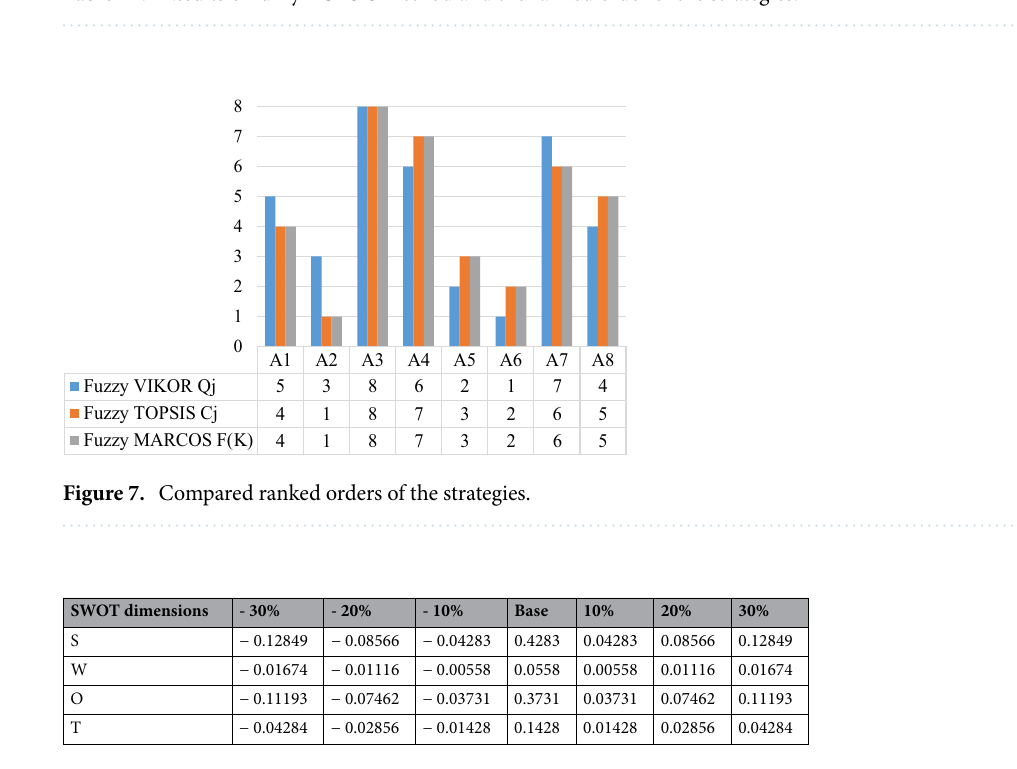
Table 13. Weight values of the SWOT dimensions in different